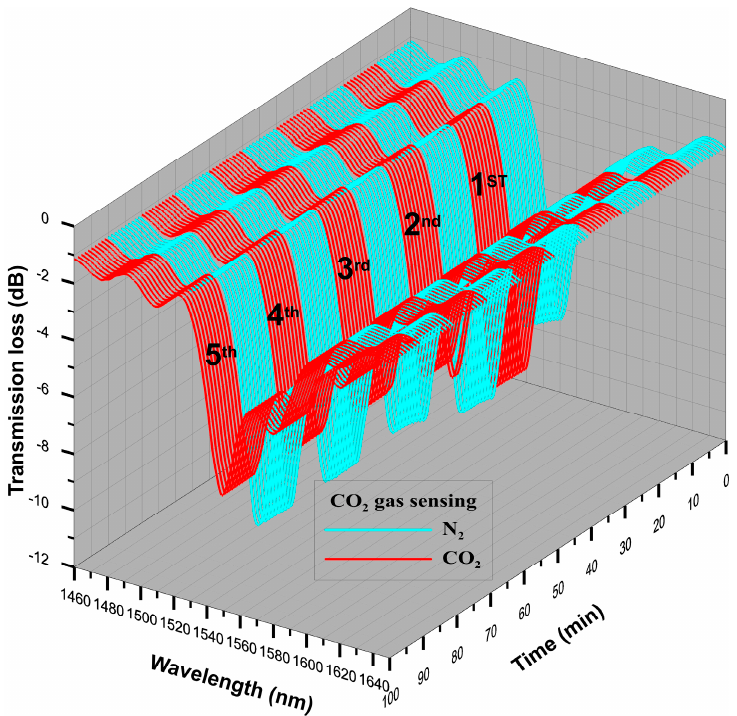
Figure 4. The spectra of the sensor in repeated (five cycle) CO 2 gas sensing experiments.